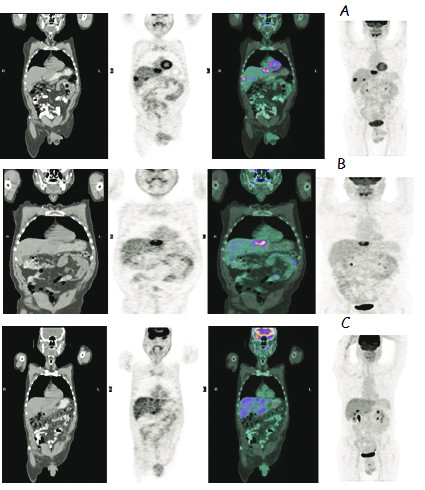
54 years-old male patient who received 1.7 GBq Y-90 microsphere therapy to the right and left lobes in separate sessions for liver metastases of colorectal cancer. 6A; coronal CT, 18F-FDG PET, fused and maximum intensity projection images of the whole body before the treatment. 6B; coronal CT, 18F-FDG PET, fused and maximum intensity projection images of the whole body after the treatment of the right lobe. 6C; coronal CT, 18F-FDG PET, fused and maximum intensity projection images of the whole body after the treatment of the left lobe.